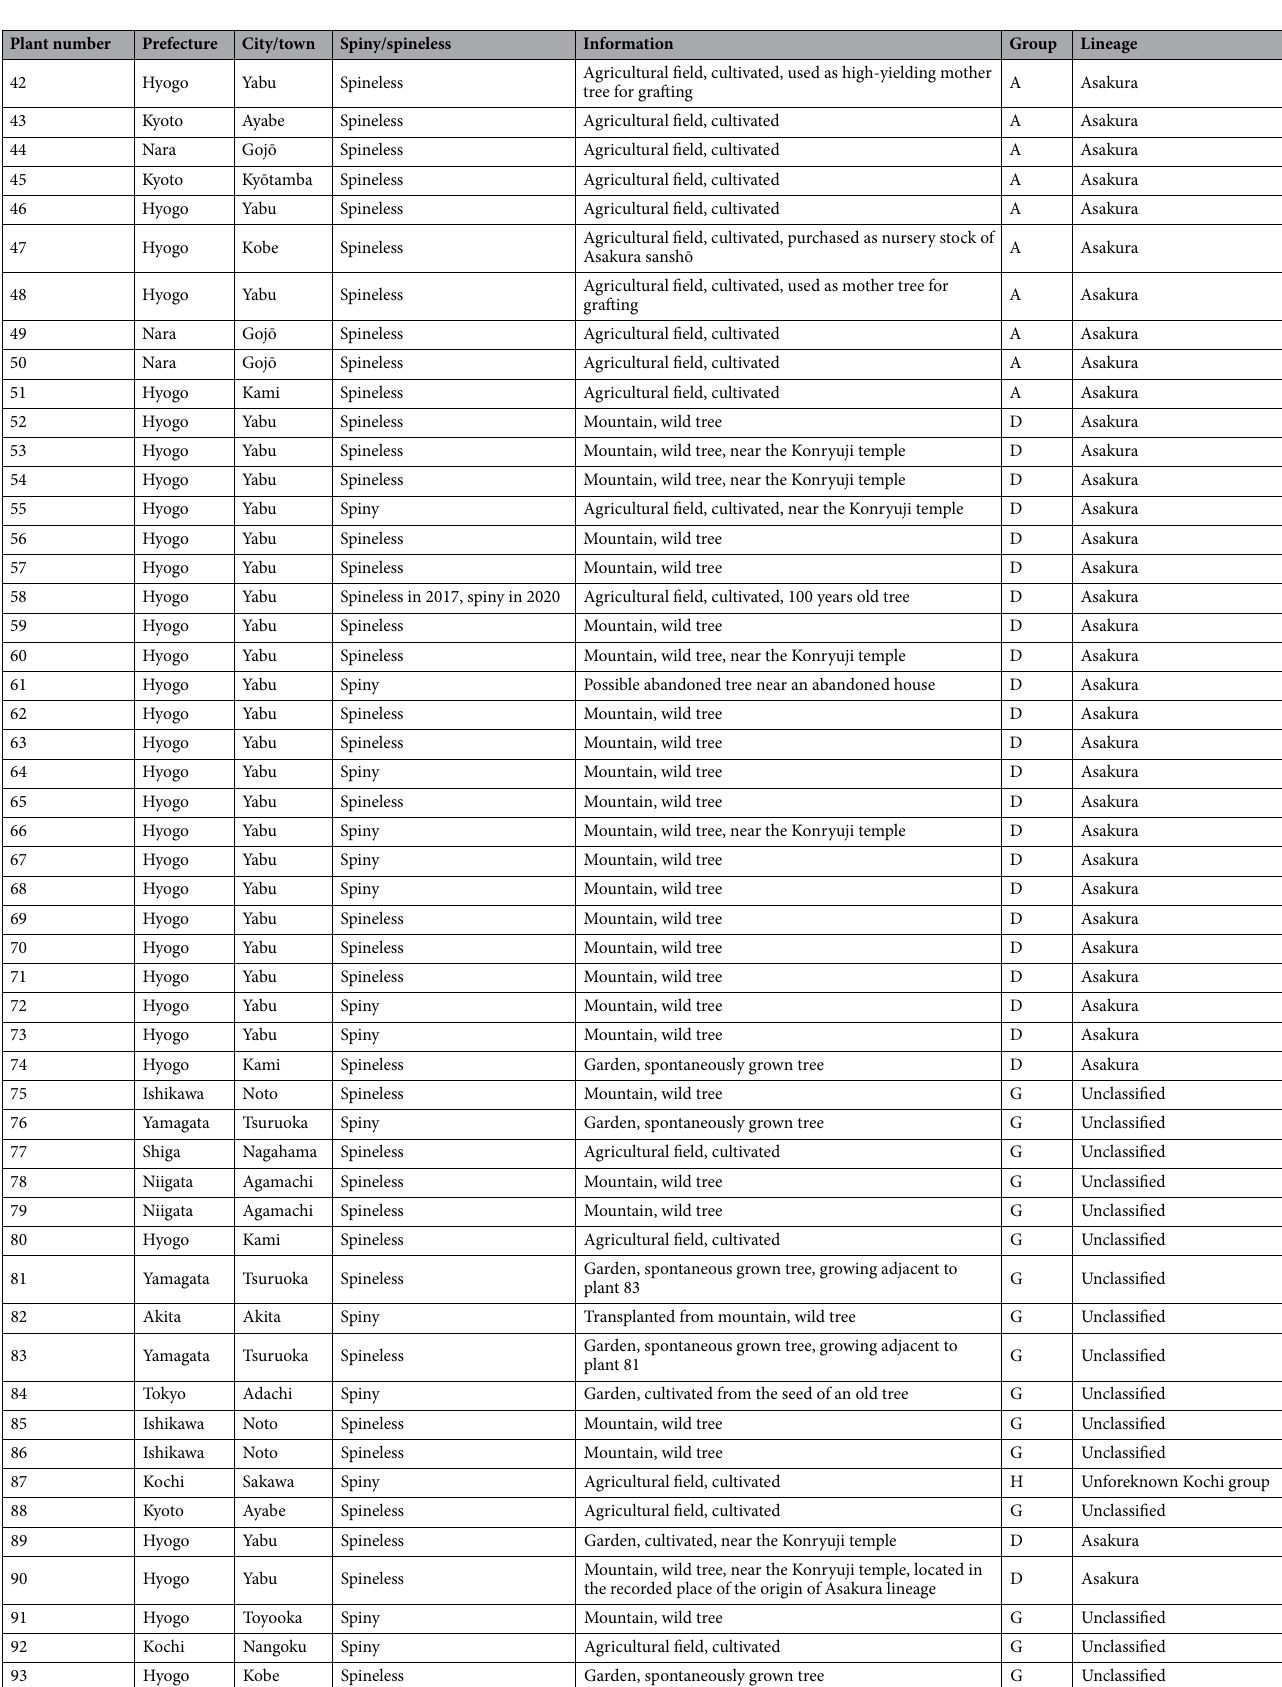
Table 1. Information on Zanthoxylum piperitum accessions used in the